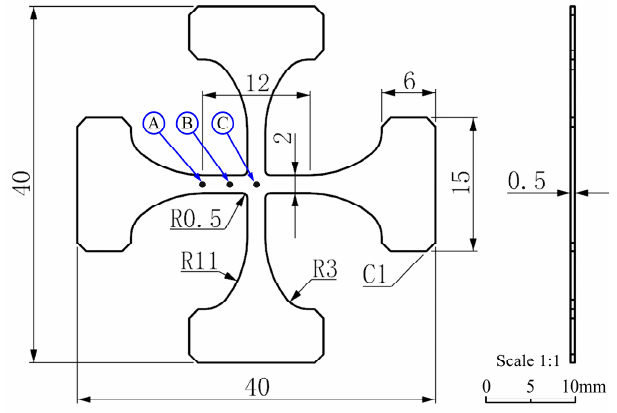
Figure 2. Specimen structure size.